Question: Express in one sentence what the figure is showing.
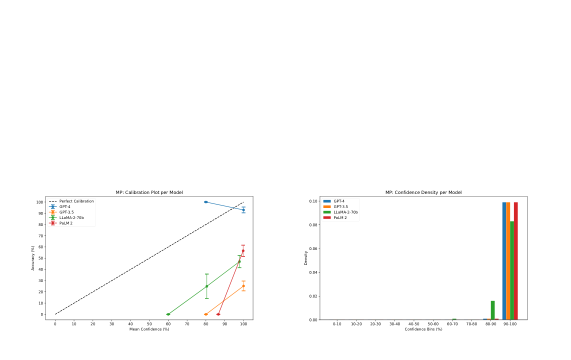
Answer: Calibration plots and confidence histograms for the math word problems task. All models exhibit excessive overconfidence except for GPT-4, and all mod- els output extremely high confidence in their answers.